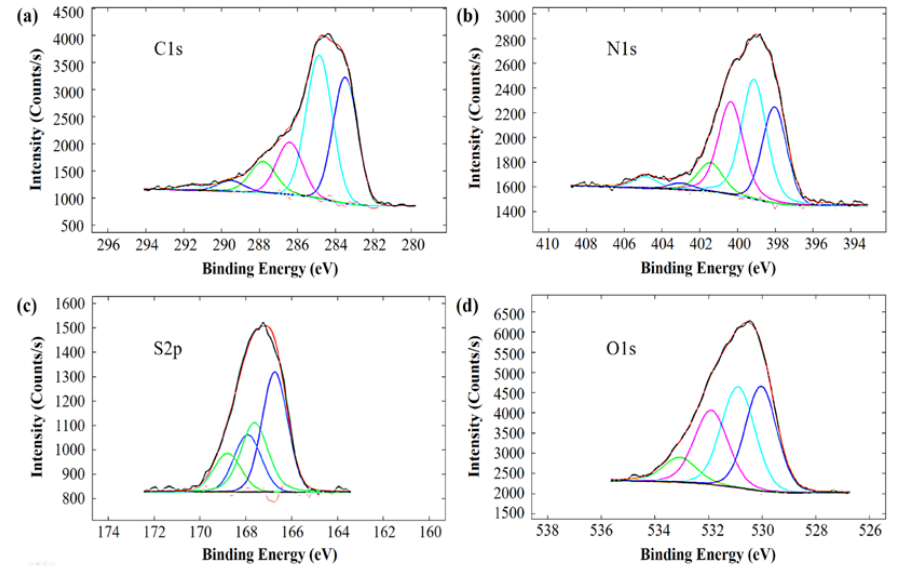
Figure 4. High resolution XPS spectra and corresponding deconvolution peaks for ( a ) C1s; ( b ) N1s; ( c ) S2p; and ( d ) O1s of NSPC foam. Deconvolution peaks are showed in color underneath experimental signals in black. Table 1. Summary of chemical analysis of NSPC foam as determined by XPS.